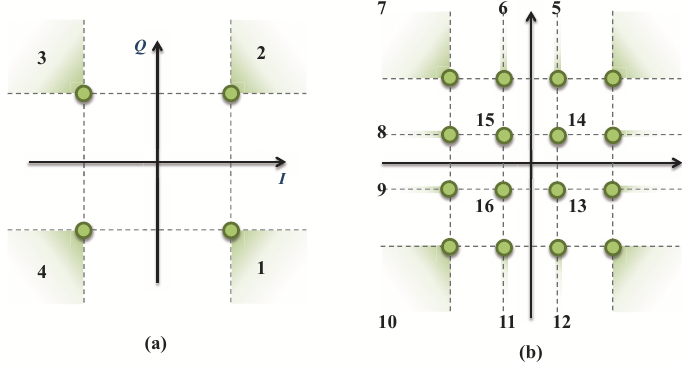
Figure 3. QPSK and DCM ACE